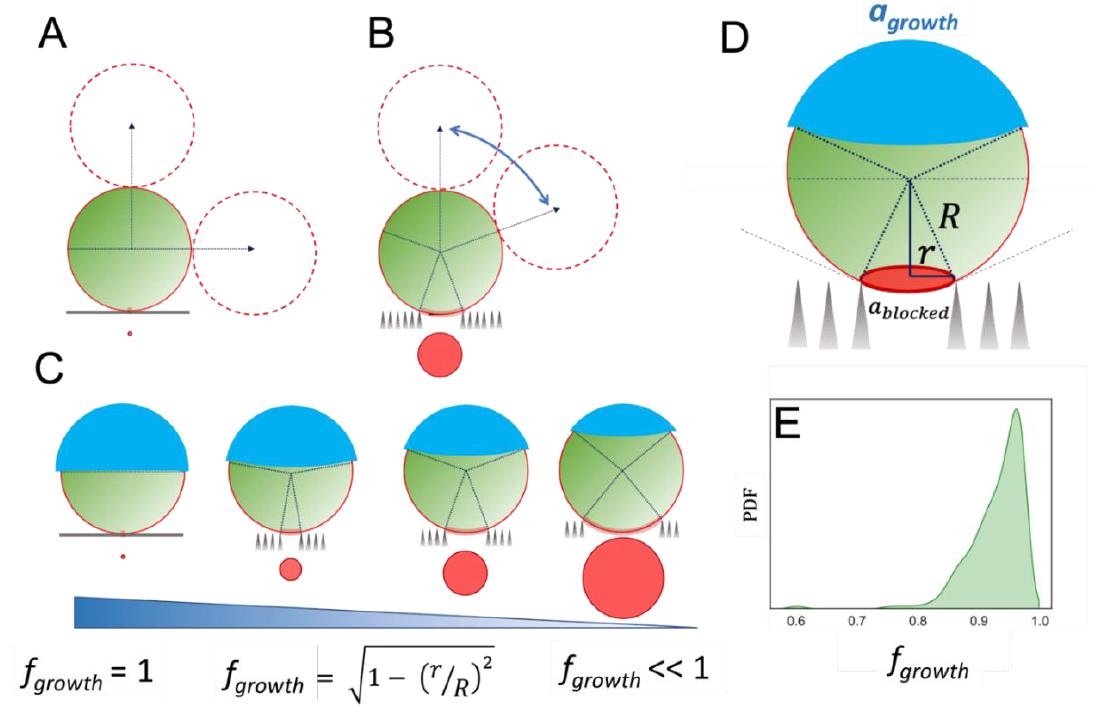
Figure 5. Effect of local topography on cell growth and division: ( A ) On a flat surface, any orientation angle is allowed for subsequent cell division. ( B ) In the presence of a topographic cavity, the allowed angles for subsequent cell division are restricted by the boundary of the cell that lies within the topographic cavity, as shown in red. ( C , D ) The topographic restriction of the cavity generates a hindered zone on the cell wall, determined by the maximum red circle inscribed in the cavity ( D ). This also defines the fraction of cell area f growth where cell division is allowed, depicted in blue ( C , D ). In the equation displayed in ( C ), r stands for the pore radius and R for the radius of Staphylococcus spp. cells as illustrated in ( D ). ( E ) Probability density function for f growth on SiNW surfaces weighted by the pore area.